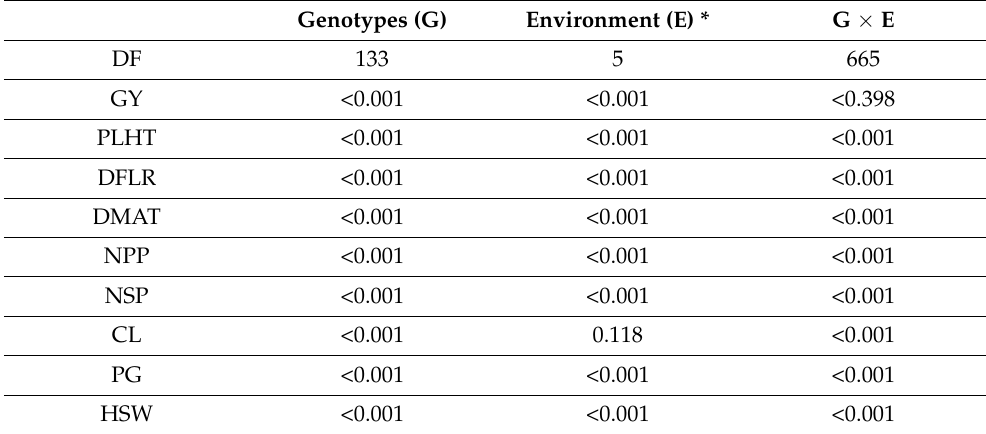
Table 2. Combined analysis using residual maximum likelihood (REML) for detecting significance differences in genotypic variation of phenotypic and physiologic traits, expressed as p